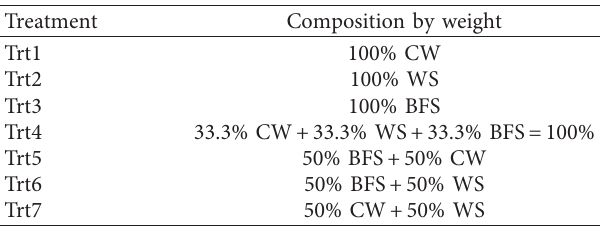
CW: cotton waste; WS: wheat straw; BFS: baobab fruit